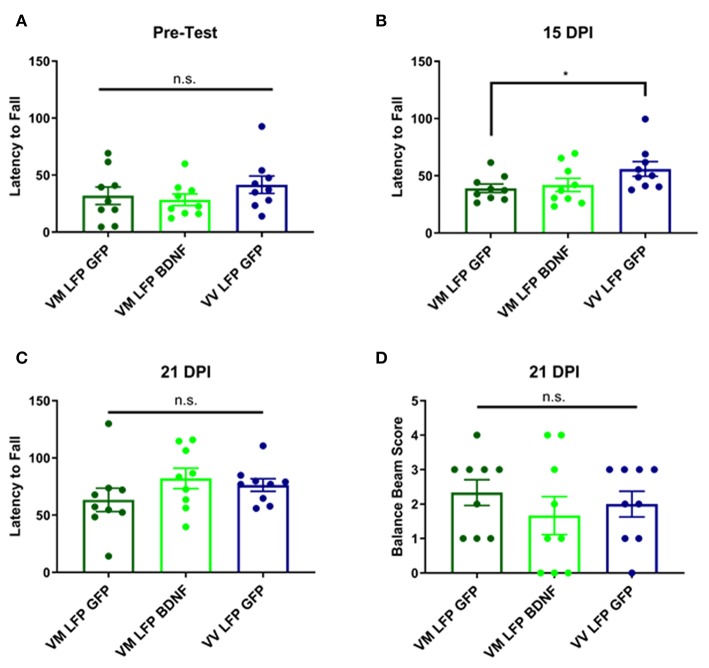
Repeated mild LFP injury causes a deficit in vestibular motor function at 14 days in injured Val66Met mice relative to injured Val66Val. Treatment with AAV-BDNF does not significantly improve this deficit. (A) Quantification of latency to fall in the rotarod pretest assay ± SEM (B) Quantification of the latency to fall in the rotarod assay ± SEM at 14 DPI and (C) 21 DPI. (D) Quantification of balance beam score ± SEM at 21 DPI. *p < 0.05, ANOVA Fisher's PLSD post-hoc test relative to indicated groups, n = 9.